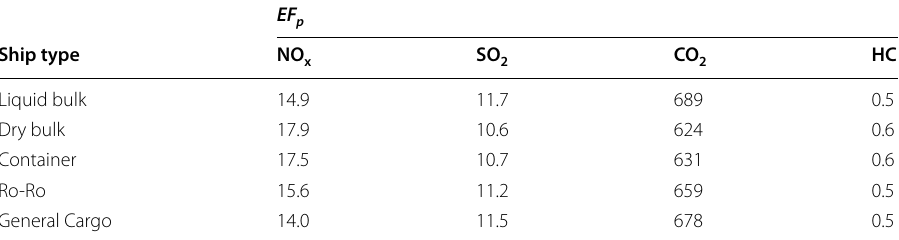
Table 9 Emission factor by ship type (g/KWh). Source Elaboration on Whall et al.